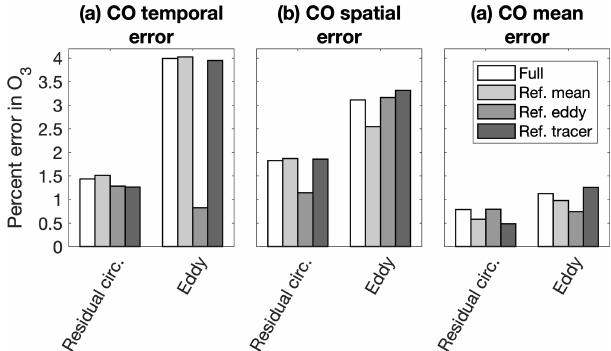
Figure 17. As in Fig. 16 but for carbon